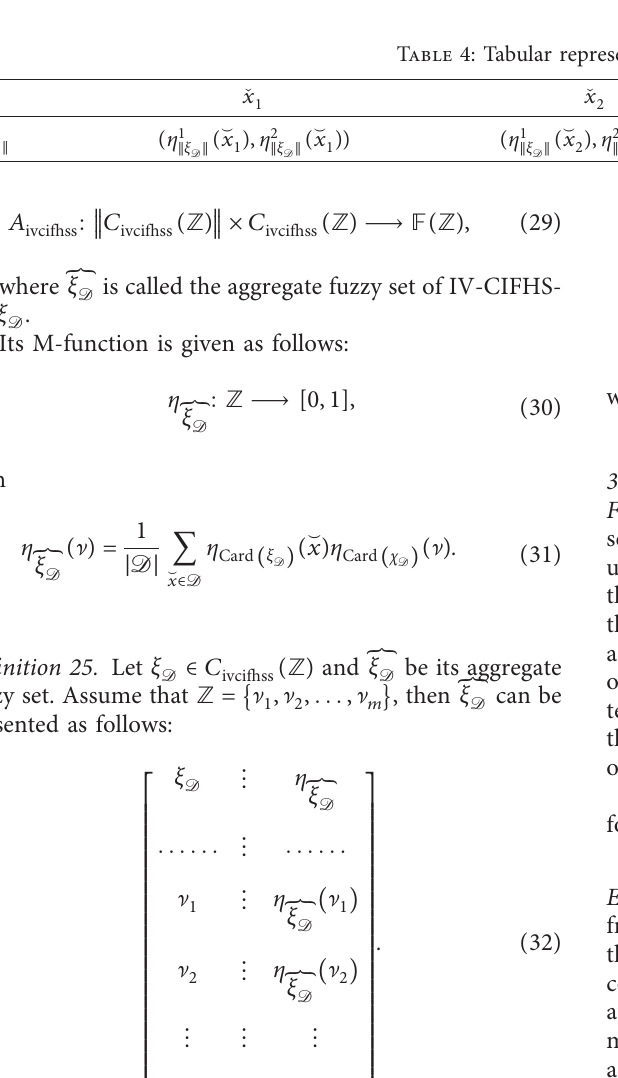
Table 3: Tabular representation of ξ